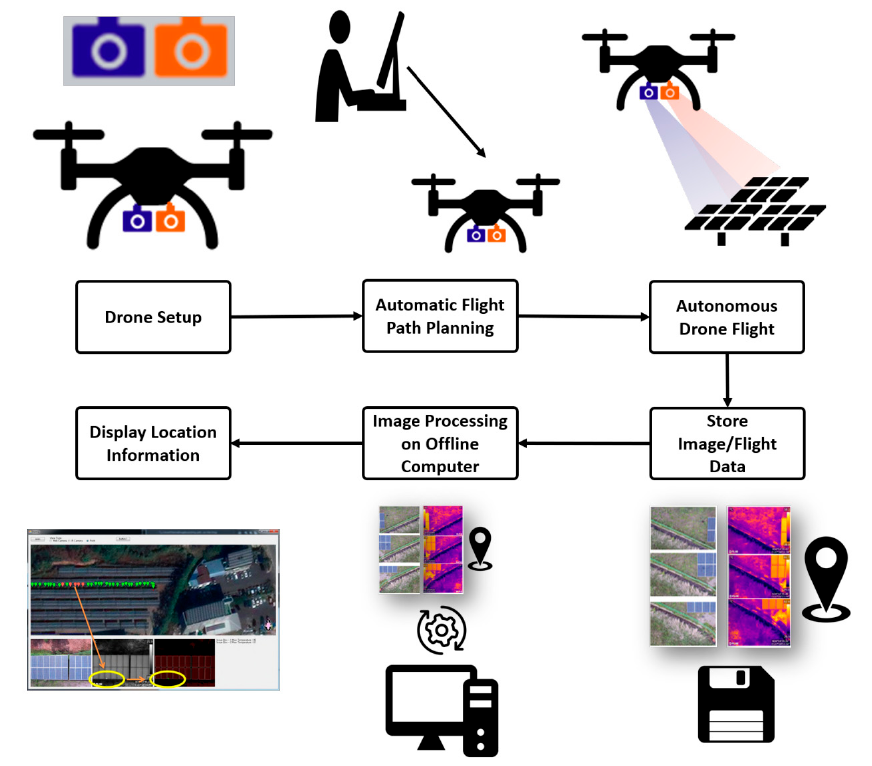
Figure 6. Block diagram displaying the system configuration of an automatic detection process of faulty PV modules using drones [46].